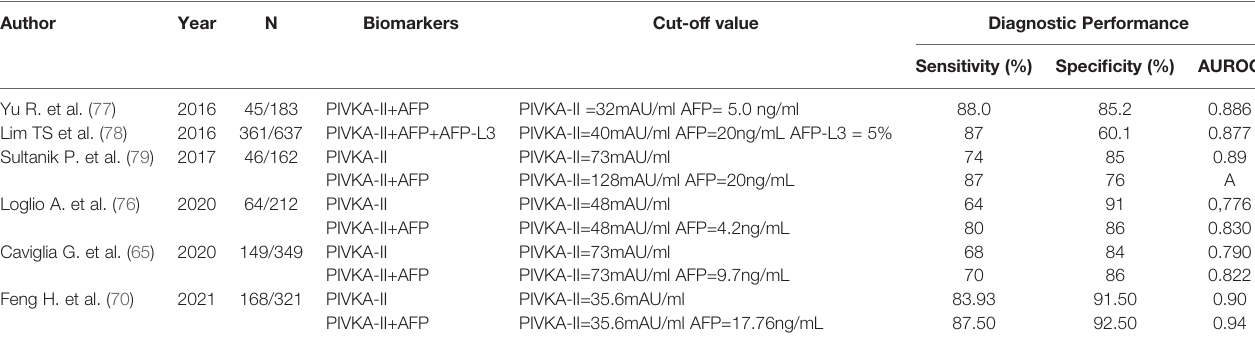
TABLE 1 | Studies of diagnostic performance of PIVKA-II and its combinations in